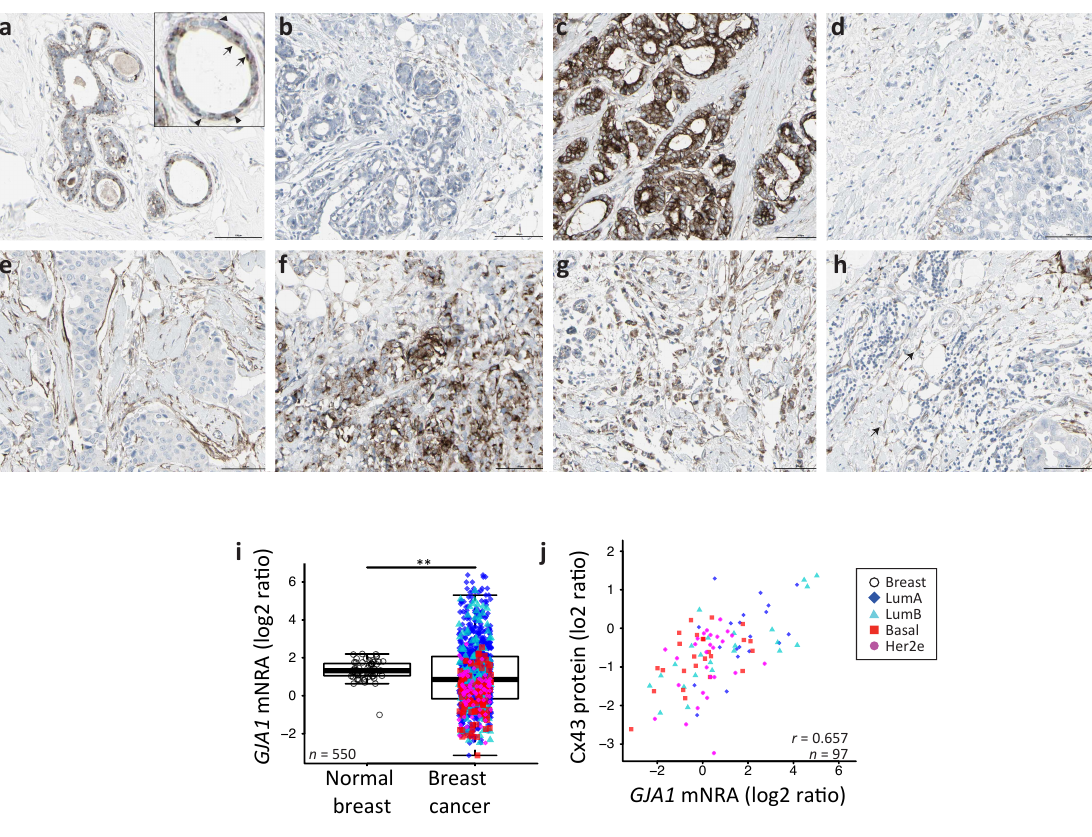
Figure 1. ( a – h ) The Human Protein Atlas normal and breast cancer tissue staining by immunohistochemistry for Connexin 43 (Cx43) (CAB010753 antibody). ( a ) Normal breast. Insert: Arrow head: myoepithelial cell’s staining; arrow: luminal cell’s staining. ( b–h ) Breast cancer tissue, ( h ) arrow: staining of spindle shaped stromal cells. Scale bar = 100 µ m. ( i ) GJA1 mRNA expression in breast tumor vs. adjacent normal breast tissue in the The Cancer Genome Atlas (TCGA) dataset. p value: * <0.05; ** <0.01; *** <0.001. ( j ) Scatter plot showing Cx43 protein and GJA1 mRNA level in tumors. In the legend, “Breast” indicates adjacent normal breast tissue. Pearson’s correlation coefficient is given